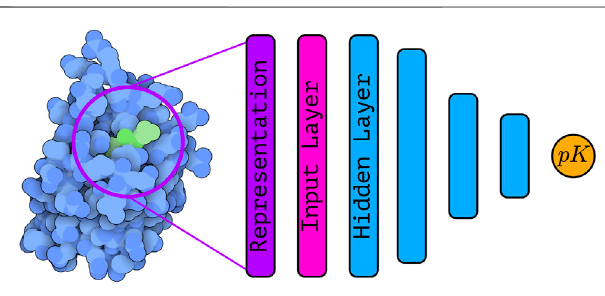
FIGURE 1 | | Schematic representation of a structure-based deep learning architecture — with several hidden layers — for binding af fi nity prediction.Theprotein-ligandcomplex(PDBID:5S9H,renderedwithIllustrate (Goodsell et al., 2019a)) is encoded into a suitable representation that is used as input to the deep learning architecture. Using a series of stacked hidden layers, a prediction of the binding af fi nity is fi nally obtained. The exact nature of the input layer as well as the hidden layers depends on the type of architecture under